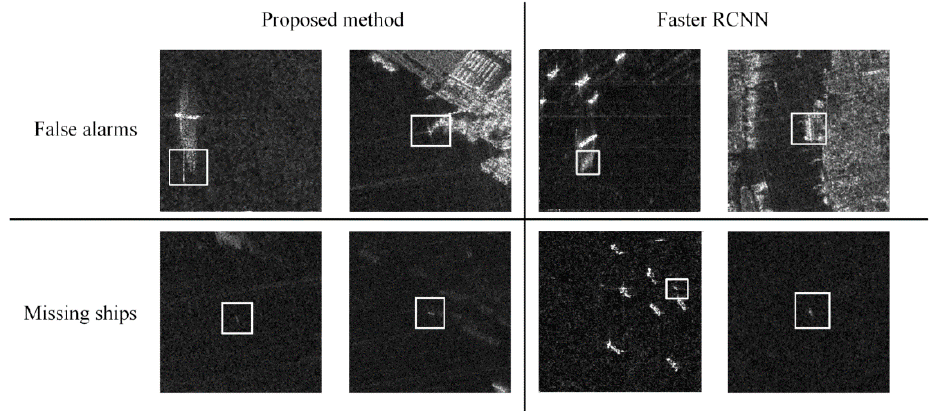
Figure 9. Demonstrations of typical false alarms and missing detection ships of the proposed method and Faster RCNN, which are marked by white boxes.